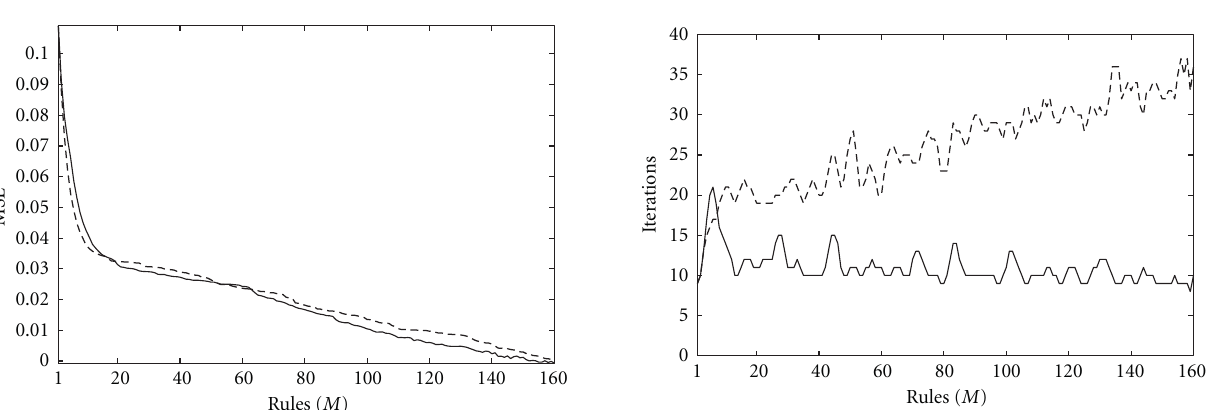
Figure 11: Prediction accuracy of the HCS algorithm: single execution in HHCS (continuous line); best execution in OHCS (dashed line).